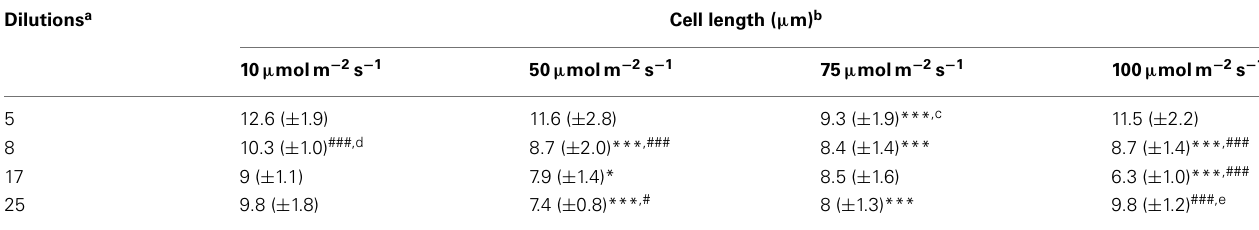
FIGURE 1 | Experimental set-up for examining the impact of different intensities of green light (GL) on the regulation of cellular morphology in the chromatically adapting cyanobacterium Fremyella diplosiphon UTEX 481 wild-type (WT). A liquid culture of F. diplosiphon WT was initiated in BG-11 culture medium containing 20mM HEPES (BG-11/HEPES) from a culture growing on a BG-11/HEPES plate under white fluorescent room light